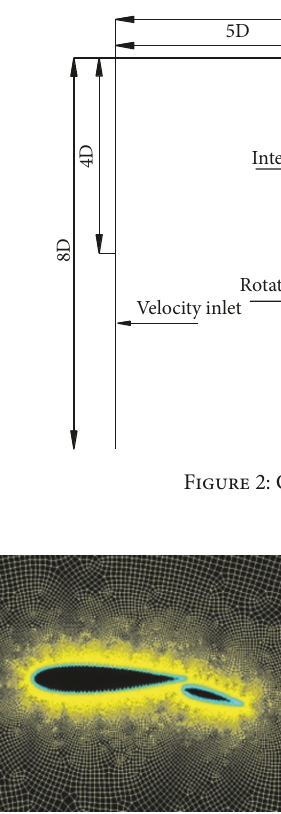
Figure 3: Mesh around blades.